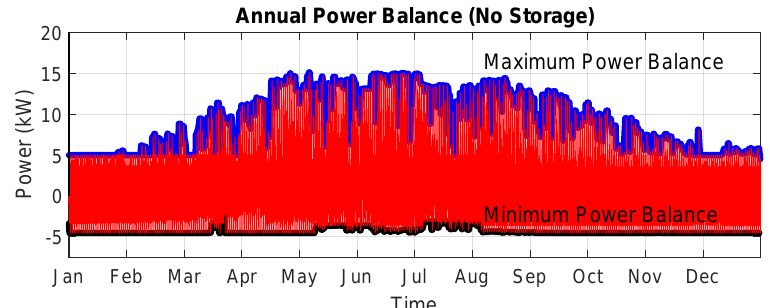
Figure 5. Annual power balance of the system with no storage unit implemented. The rainflow algorithm, which is explained in details in [27], is used to extract the cycle lengths of the power balance in order to gain insights in the charging and discharging time of the storage unit. From applying the rainflow algorithm, it is revealed that 93 percent of all power balance cycle lengths are covered within a time duration of three hours, both